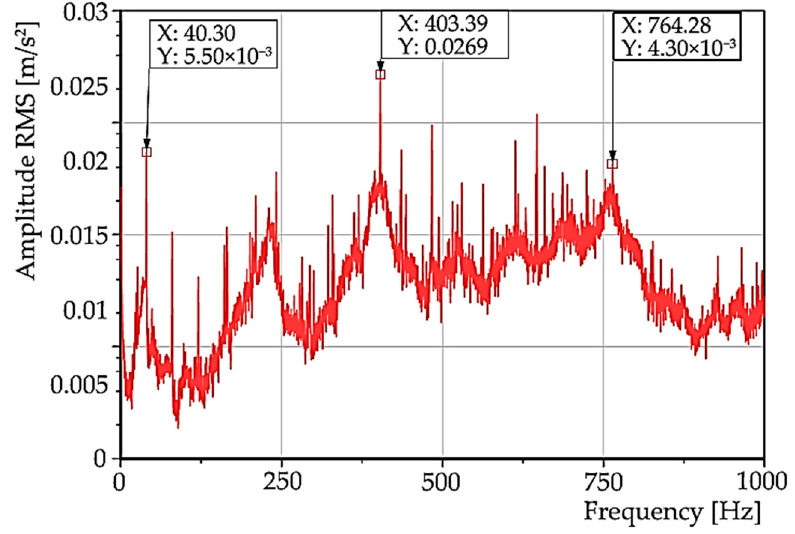
Figure 19. The spectrum of the effective acceleration value in logarithmic scale.